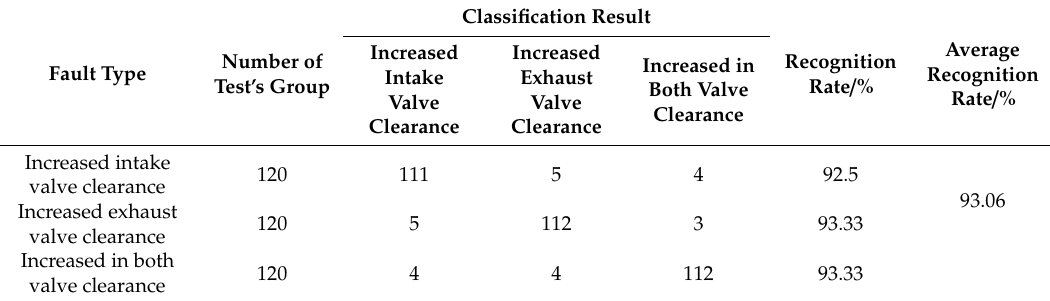
Table 7. Confusion matrix.